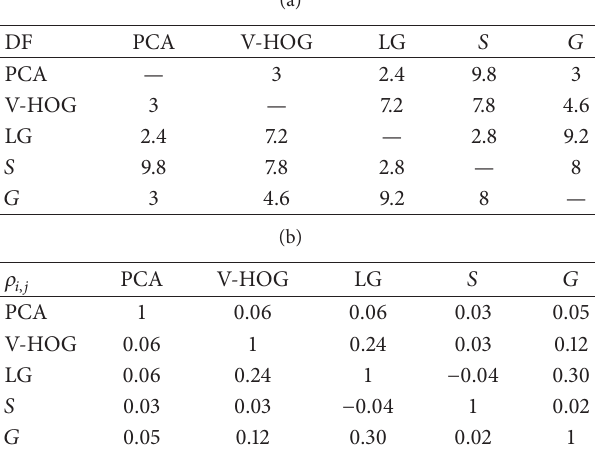
Table 8: Diversity measures for the front close/middle region: (a) Double Fault (DF) and (b) correlation coefficient. The DF is given as an absolute number rather than a probability for easier interpreta- tion. For instance, PCA and V-HOG make only simultaneous errors on 3 samples of the total testing set of 1000